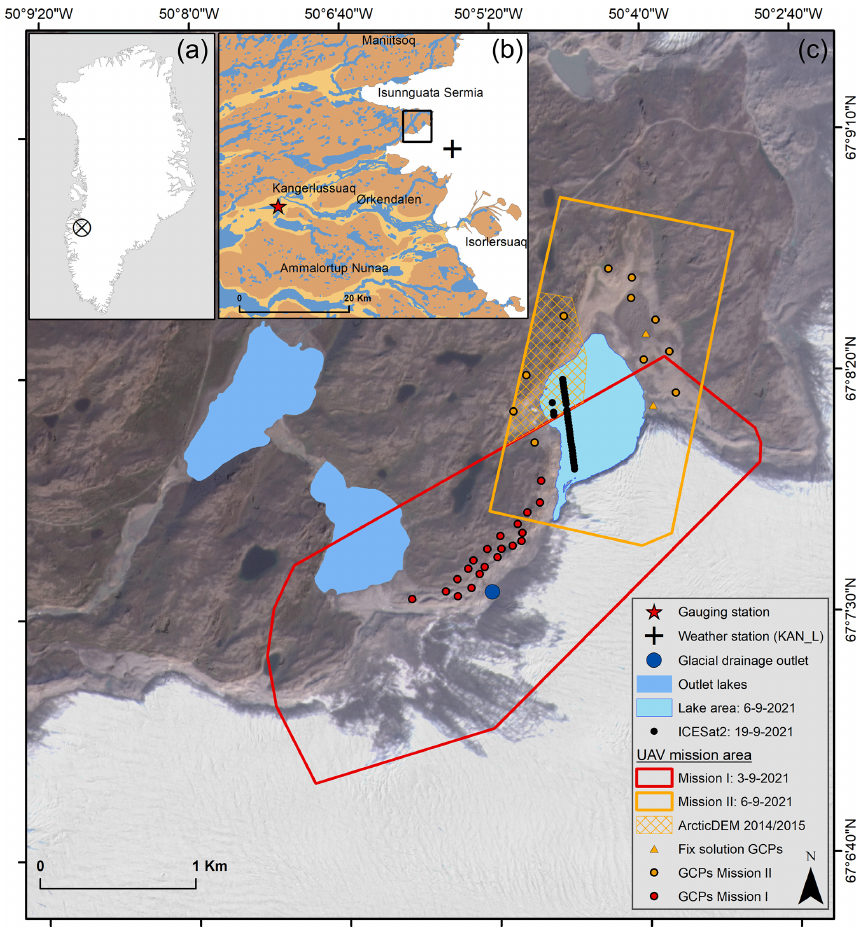
Figure 1. (a) Study site location in Greenland. (b) Close-up of the study site with location of the gauging station and the PROMICE (Programme for Monitoring of the Greenland Ice Sheet) weather station. (c) UAV mission area I and II with location of GCPs overlaid on a four-band Planet Team (2017) acquisition from 23 August 2021. The yellow triangles illustrate the only two reliable fix solution GCPs. Due to image gaps at the western part of the lake, the produced UAV DEM is filled with elevation data from two ArcticDEMs acquired on 19 September 2014 and 2 August 2015.